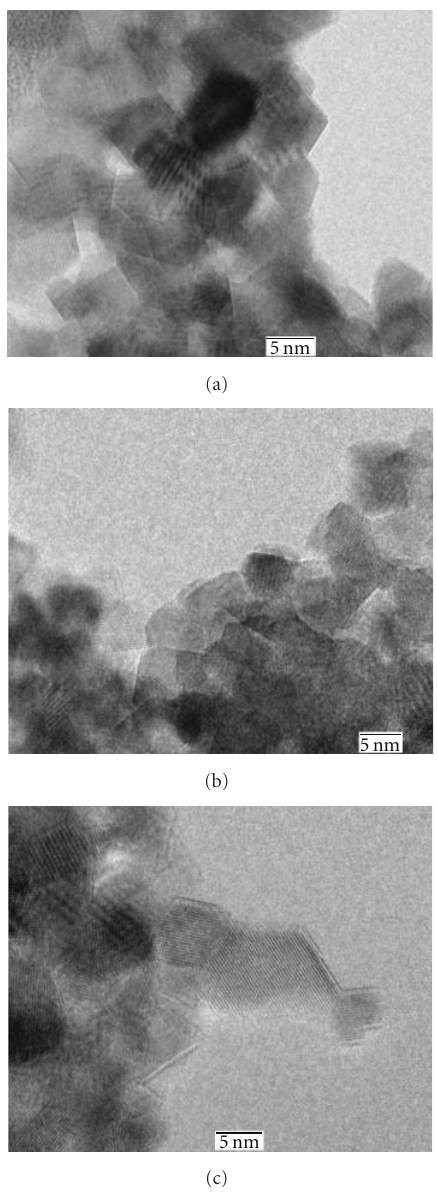
Figure 1: TEM images of the as-prepared catalysts. (a) RuPd, (b) RuRh, and (c)